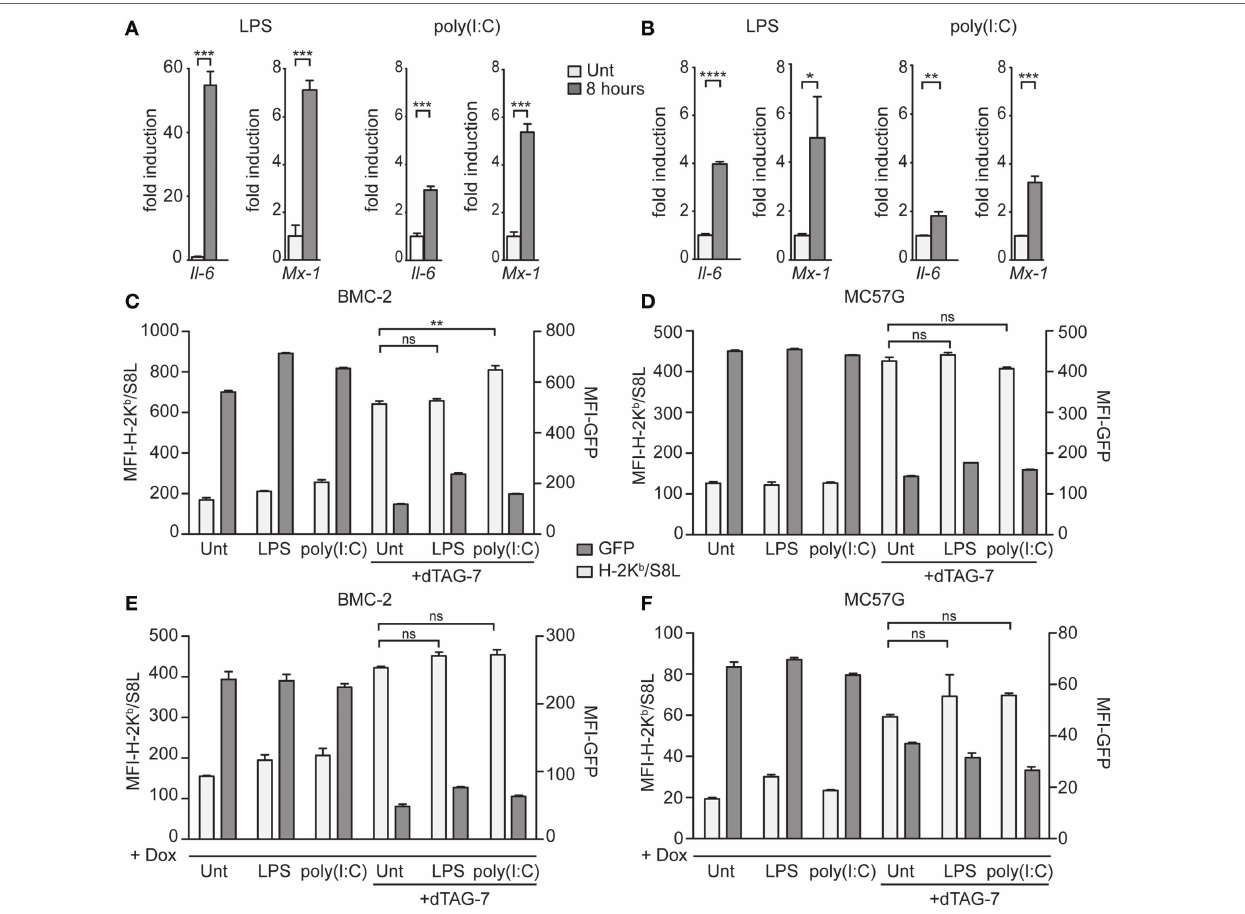
FigUre 5 | Degradation tag (dTAG)-7-mediated antigen presentation is not altered by immune stimulation. (a,B) Real-time PCR analysis of the inflammatory genes Il-6 and Mx-1 , 8 h after treatment of BMC-2 (a) and MC57G cells (B) with either 20 ng/mL lipopolysaccharide (LPS) or 6 µg/mL poly(I:C). Results are shown as fold induction compared to the untreated control (Unt). Gene expression was normalized to the housekeeping gene Eef1a1 . (c,D) GFP-S8L-F12-expressing BMC-2 cells (c) or MC57G (D) were treated with LPS and poly(I:C) for 24 h to induce the expression of inflammatory genes. Next, cells were incubated in the presence or absence of 1 µM dTAG-7 for 2 h, before GFP-specific fluorescence (MFI-GFP) and presentation of GFP-S8L-F12-derived S8L (MFI-H-2K b /S8L) was detected by flow cytometry. MFI, mean fluorescence intensity. (e,F) BMC-2 (e) and MC57G (F) cells were simultaneously treated with toll-like receptor agonists and 1 µg/mL doxycycline (Dox) in the presence or absence of 1 µM dTAG-7. After 6 h, MFI-GFP and MFI-H-2K b /S8L were detected as described above. All experiments were performed in triplicates and results are shown as mean ± SEM. Representative results from three independent experiments are